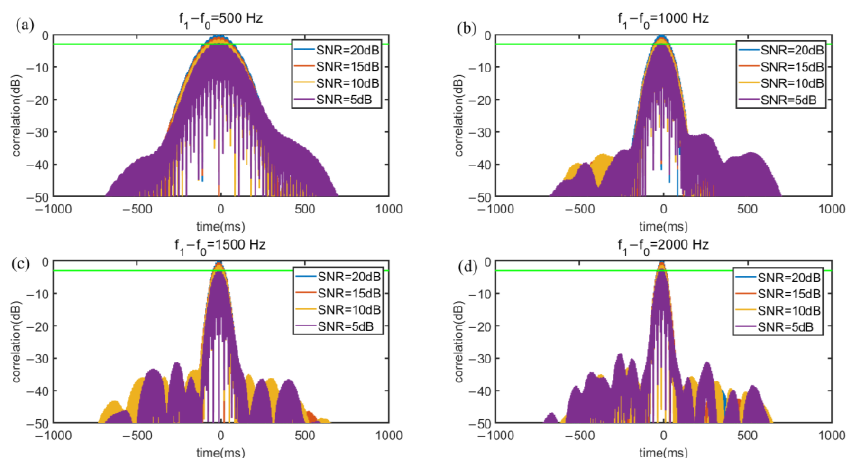
Figure 9. Autocorrelation power spectrograms of different bandwidths in the case of Gaussian noise with fixed T = 20 ms. ( a ) bandwidth = 0.5 kHz, IRW = 4.7 ms ( b ) bandwidth = 1 kHz, IRW = 2.7 ms ( c ) bandwidth= 2 kHz, IRW = 1.5 ms ( d ) bandwidth = 2.5 kHz, IRW = 1.1 ms.